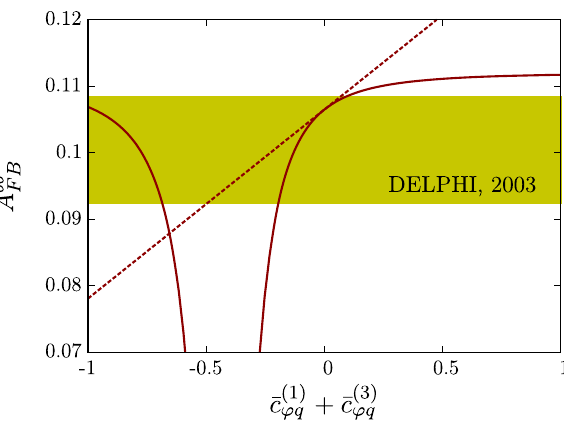
Fig. 10 Forward–backward asymmetry (linearised, dashed , and full ( 3 ) ( 1 ) results, solid ) as a function of c ϕ q + c ϕ q . The exclusion contour is taken from DELPHI collaboration’s Ref. [59] for the most constraining √ s = 91 . 26 GeV measurement at